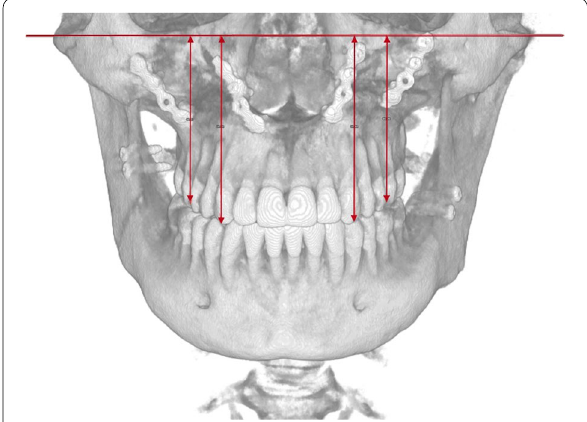
Fig. 8 View of a vertical dento-alveolar analysis in a PostOp case